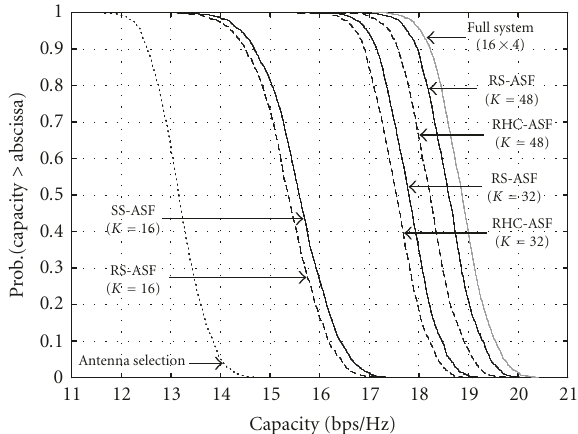
Figure 6: Empirical complementary cdf of the capacity of the re- sulted system when the Frobenius-norm-based algorithm for sev- eral schemes of receive antenna subarray formation (ASF) is ap- plied to a 16 × 4 measured channel with SNR = 15 dB. In particu- lar, the RASF schemes studied are strictly structured ASF (SS-ASF), relaxed-structured ASF (RS-ASF), and reduced hardware complex- ity ASF (RHC-ASF). K denotes the number of phase shifters or/and variable gain-linear amplifiers available to the receiver. The perfor- mance of the algorithm is compared to the full system (16 × 4) and Gorokhov et al. decremental algorithm for antenna selection.